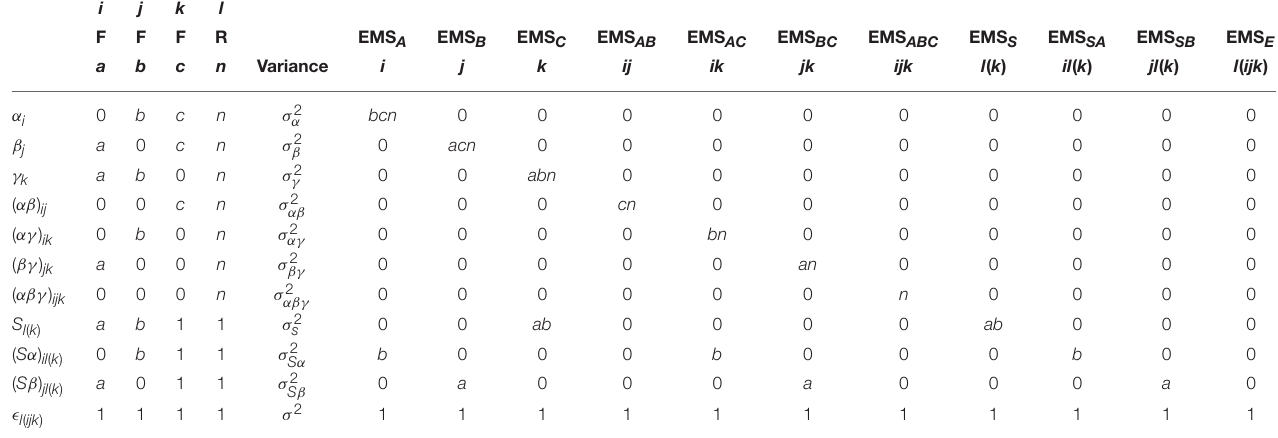
TABLE 5 | Arithmetic for the derivation of the EMS in the 3-way mixed-measures ANOVA with two within-subject and one between-subjects factor.